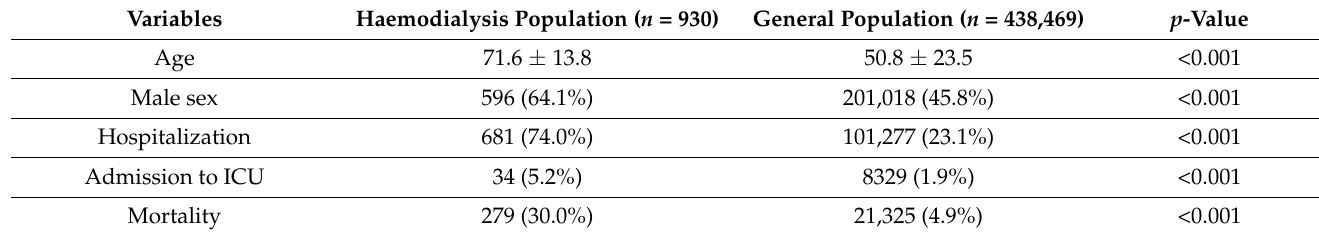
Table 2. Characteristics between haemodialysis population and Spanish general population affected by COVID-19. Values expressed in mean ± SD or n (%). ICU: Intensive Care Unit. General population data was obtained from the